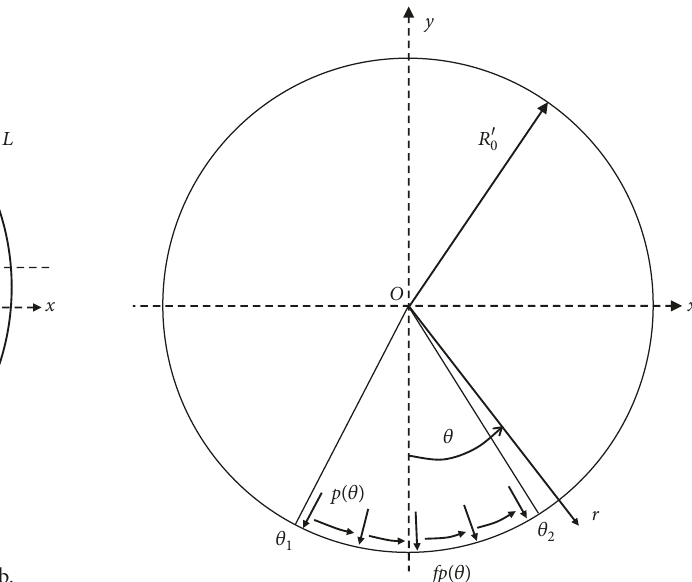
Figure 2: Design diagram of contact problem for hub.